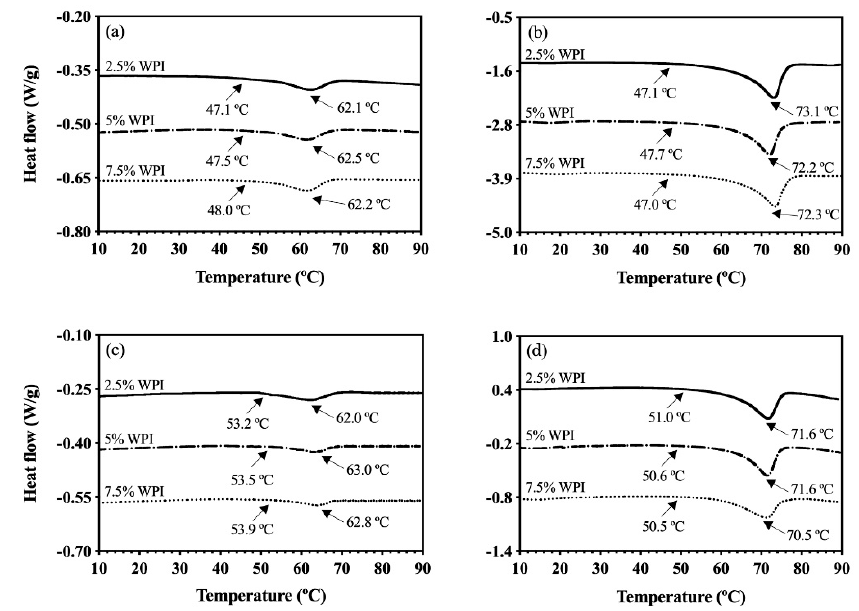
Figure 5. DSC melting thermograms of: ( a ) OC samples gelled with 1% RBW, ( b ) OC samples gelled with 10% RBW, ( c ) HOC samples gelled with 1% RBW, and ( d ) HOC samples gelled with 10% RBW. Arrows show the onset of melting and melting peak. The straight and dotted lines represent samples made with different WPI concentrations.